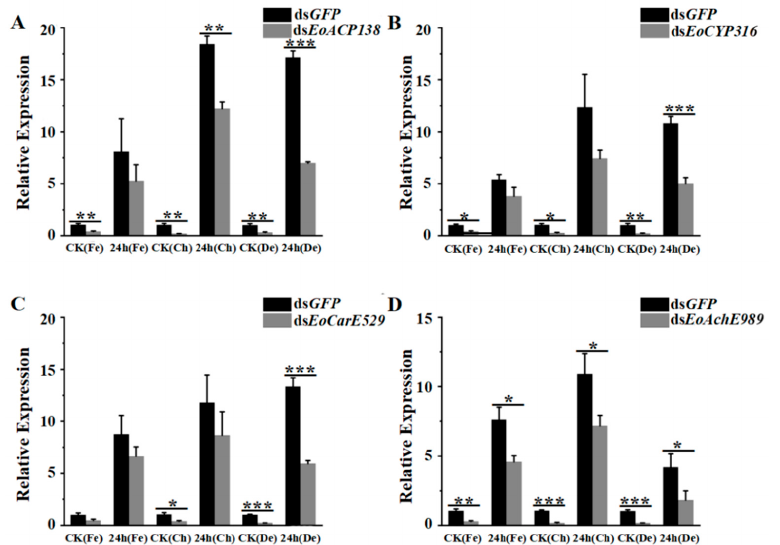
Figure 6. Transcriptional levels of detoxification related genes stimulated by fenprothrin, chlorpyrifos and deltamethrin respectively in E. oblique after RNAi. ( A ) EoACP138 . ( B ) EoCYP316 . ( C ) EoCarE592 . ( D ) EoAchE989 . Where CK was the 0 h treatment control, Fe was fenpropathrin, Ch was chlorpyrifos, and De was deltamethrin. Each bar represents the mean ± SD. * = p < 0.05, ** = p < 0.01, and *** = p < 0.001.